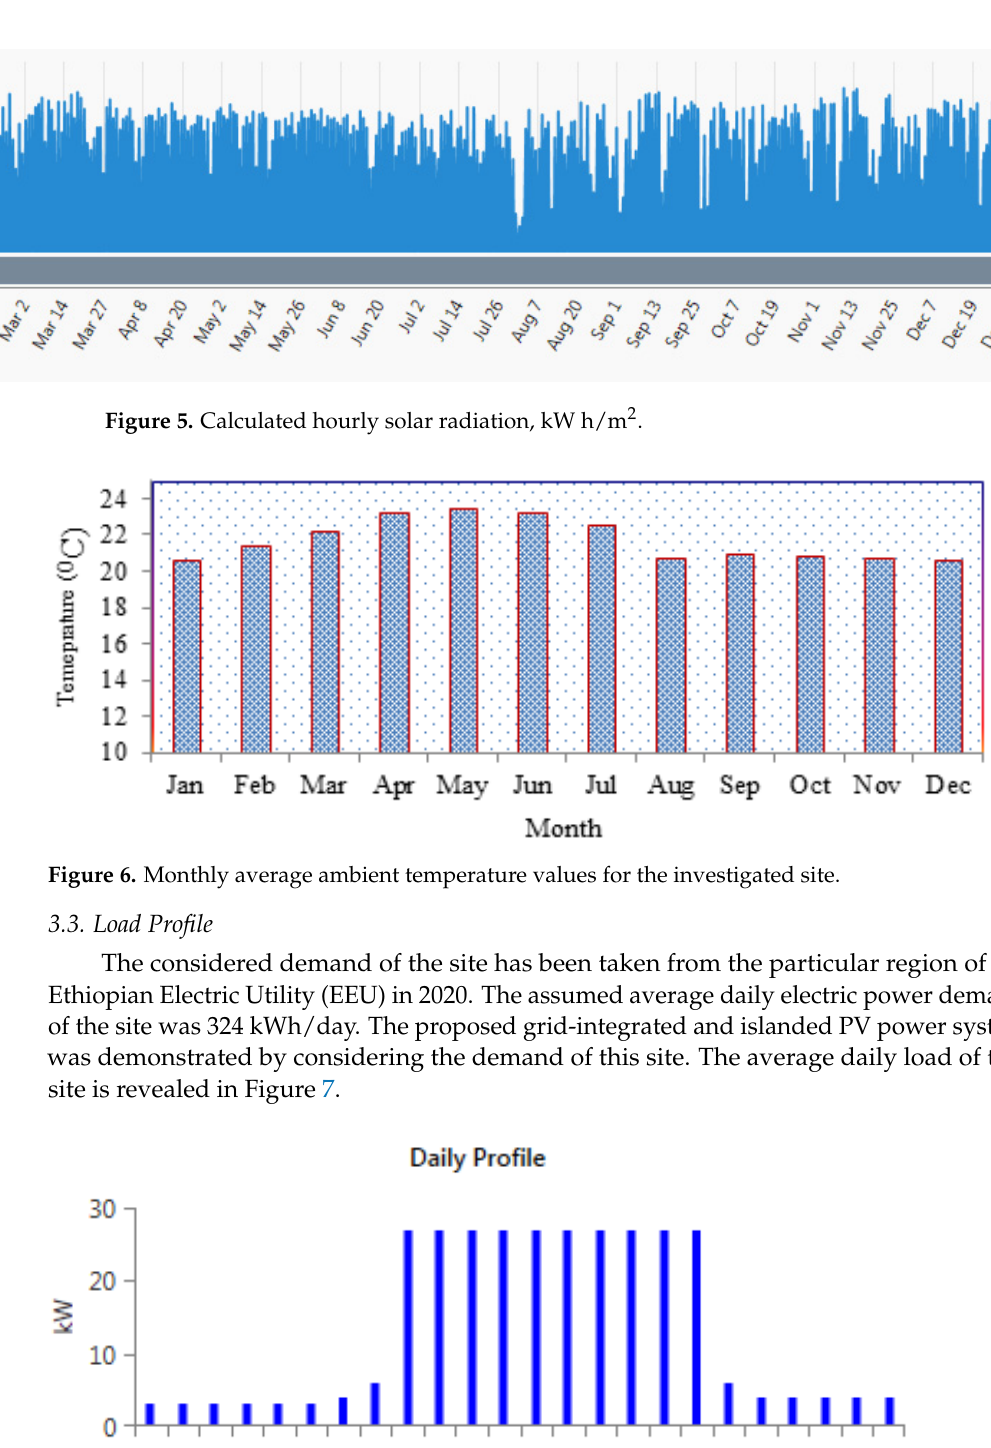
Figure 4. Monthly average analyzed, NASA, PVGIS, and PVWatts solar irradiation values for the site.